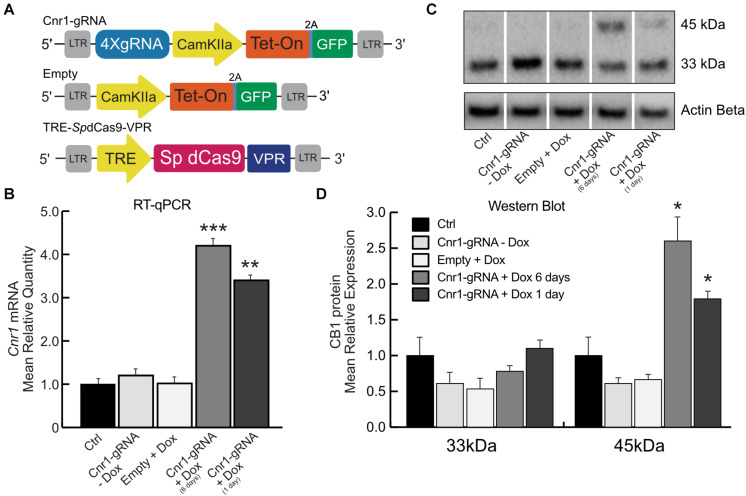
Doxycycline-inducible SpdCas9-VPR system. (A) Schematic illustrating the main components of the DoxCRISPR-Cas9 dual lentiviral system LV-TRE-SpdCas9-VPR, LV-Cnr1-gRNA-rtTA-GFP, and LV-Empty. (B) The bar graphs show the mRNA expression level of the Cnr1 gene in primary neurons transduced with the DoxCRISPR-Cas9 dual lentiviral system at two different time points (Cnr1-gRNA + Dox 1 and 6 days), compared to non-transduced (Ctrl), non-treated (Cnr1-gRNA -Dox) controls and cells transduced with LV-Empty and receiving Dox (Empty + Dox) (One-way ANOVA followed by Dunnett’s multiple comparison test, **p < 0.01 and ***p < 0.001). (C) WB analyses of total protein lysates from primary neurons. The upper panel shows the detection of the immunoreactive CB1 bands (∼33and 45 kDa) and the lower panel shows β-actin detection for loading control. (D) Expression level of the two immunoreactive CB1 bands (∼33 and 45 kDa) in primary neurons (One-way ANOVA followed by Dunnett’s multiple comparison test, *p < 0.05).